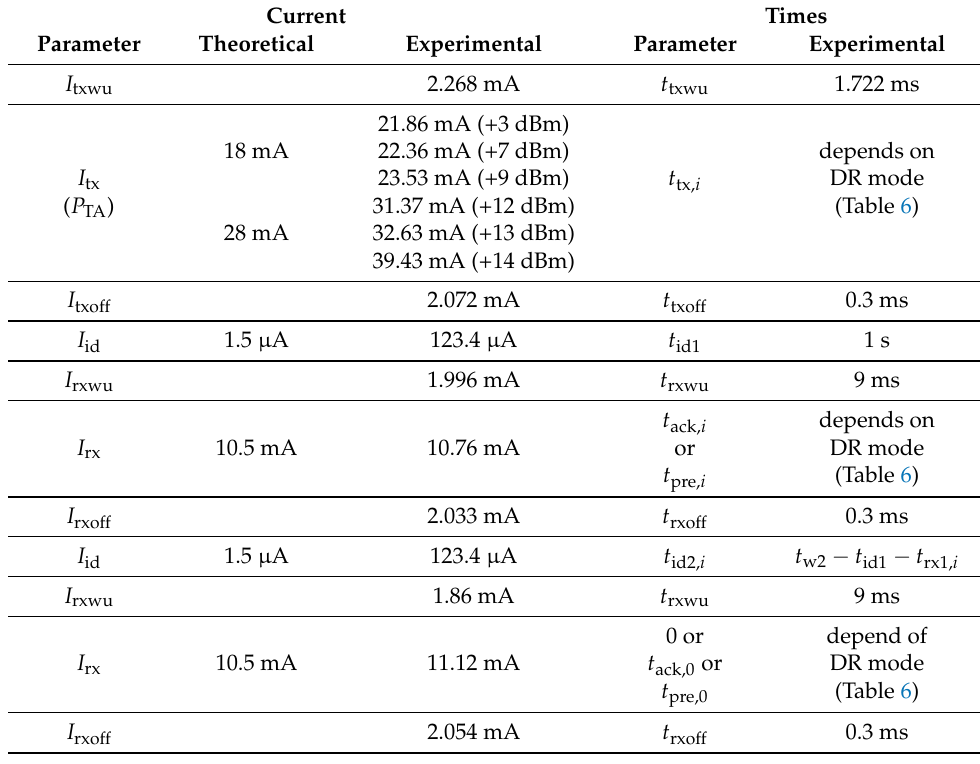
Table 5. Currents consumed in different operating states.